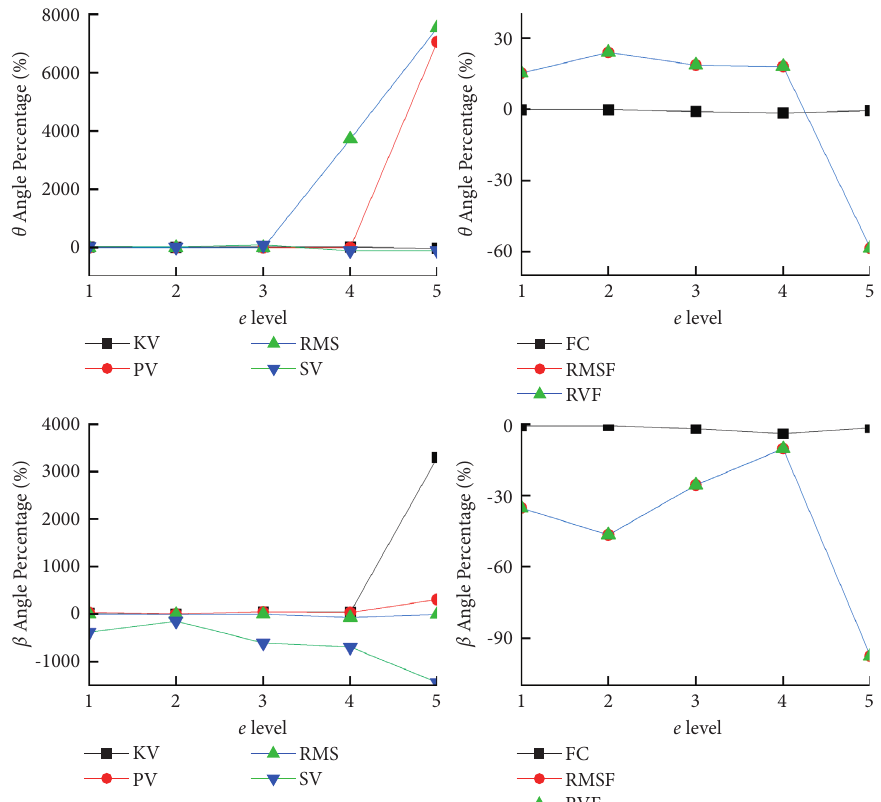
0 , and β 0 to the LSCM.